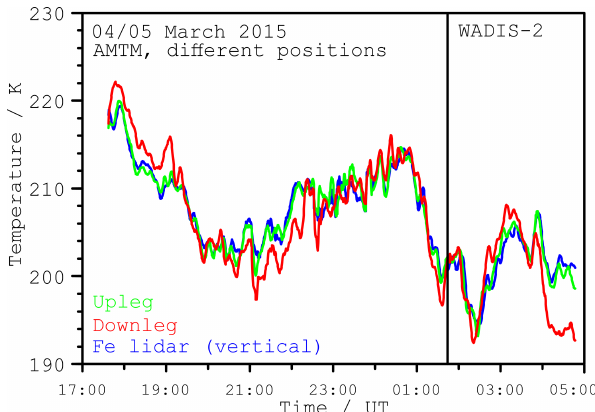
Figure 9. Temporal evolution of AMTM temperature observations derived from sub-arrays of 9 pixels × 9 pixels (about 5km × 5km) at the centre (blue), the rocket upleg (green), and the rocket downleg (red), respectively. The time series is smoothed with a Hanning filter of 5min